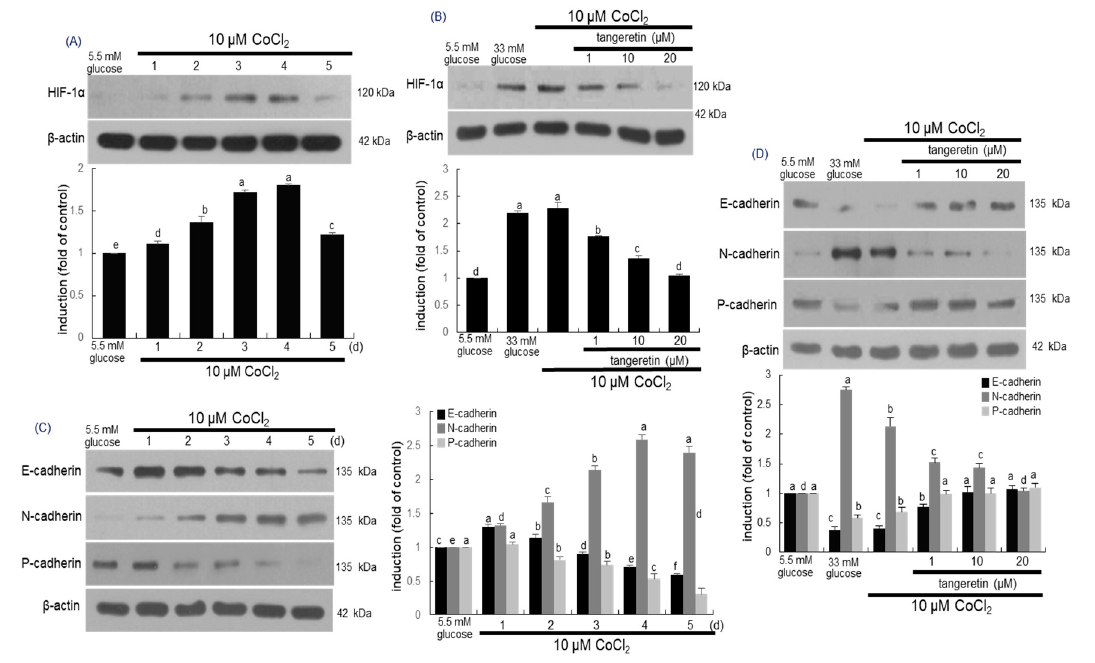
Figure 7. Temporal expression of HIF-1 α ( A ), E-cadherin, N-cadherin and P-cadherin ( C ) and their inhibition by tangeretin ( B , D ) in CoCl 2 –stimulated podocytes. Podocytes were incubated with 10 μ M CoCl 2 in the presence of 1–20 μ M tangeretin for up to 5 days. Podocyte lysates were electrophoresed on 8%–10% SDS-PAGE and subject to Western blot analysis with a primary antibody of HIF-1 α , E-cadherin, N-cadherin and P-cadherin. β -Actin antibody was used as an internal control. The bar graphs (mean ± SEM, n = 3) represent quantitative results of each blot bands obtained from a densitometer. Values in bar graphs not sharing a common letter are significantly different at p < 0.05.